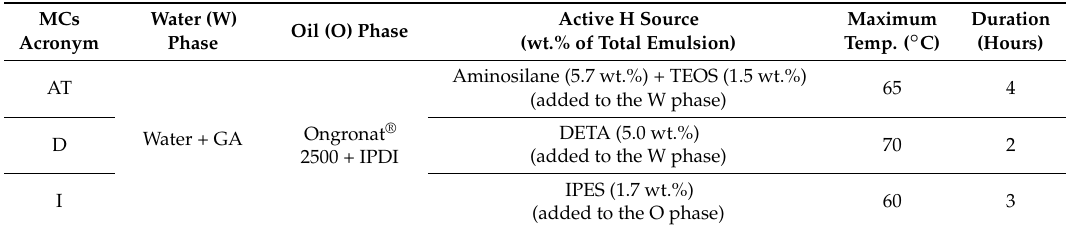
Table 1. MCs’ synthesis parameters: active H source employed, maximum reactional temperature and